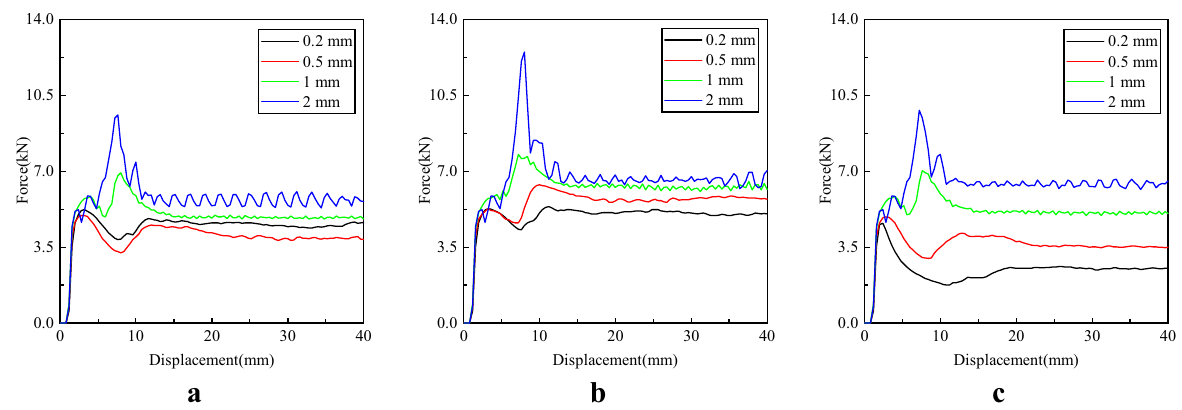
Figure 10 Force–displacement curves of 3 failure models: a r